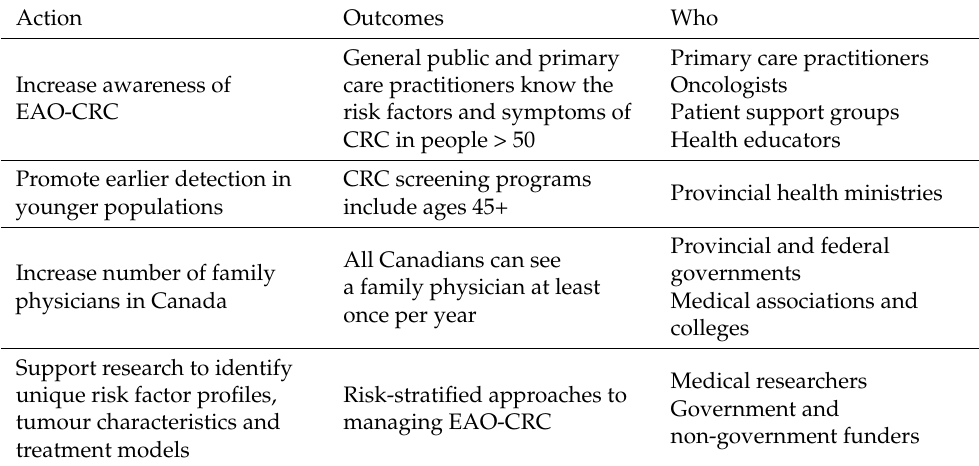
Table 2. Summary of key actions from